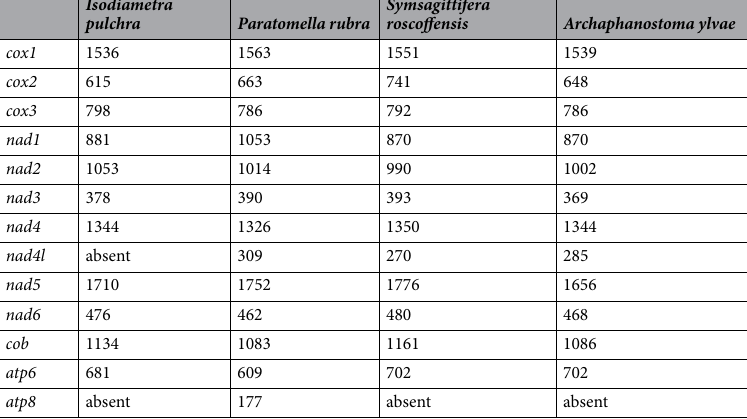
Table 4. Length of protein–coding genes in acoel mitochondrial genomes. All gene lengths in base